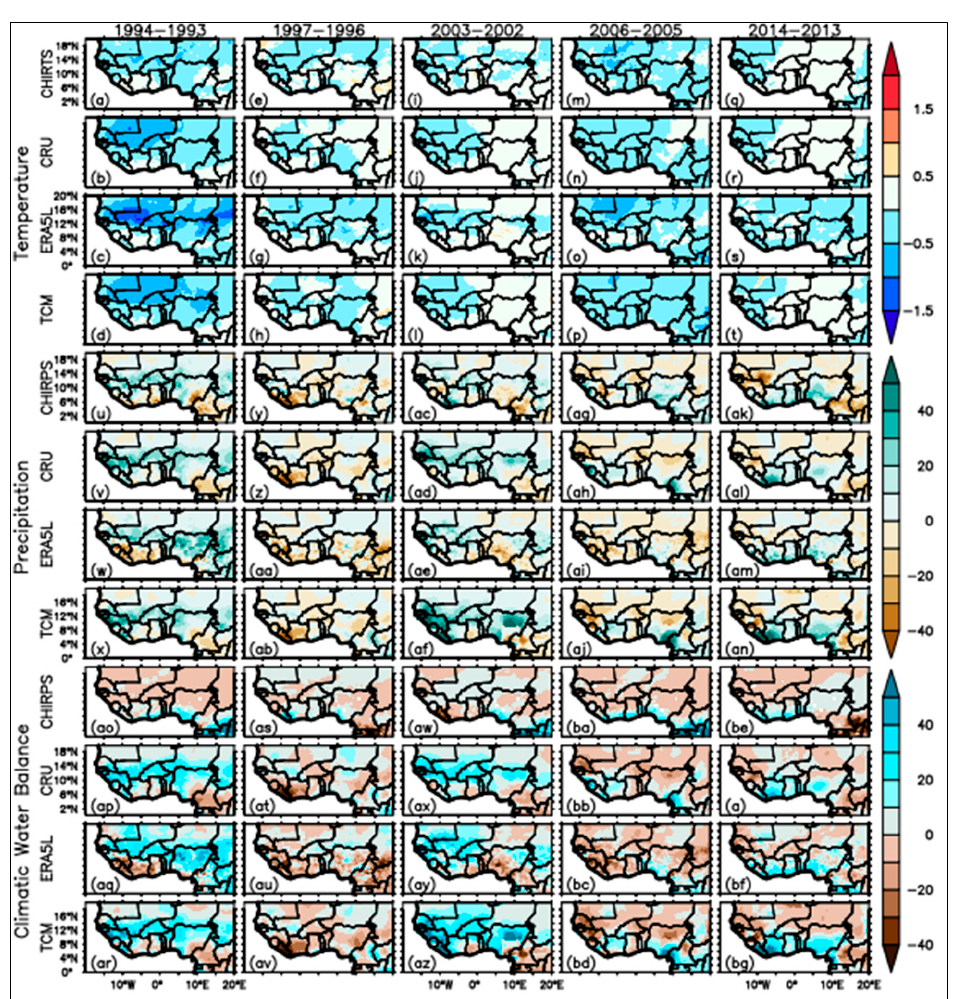
Figure 10. ( a – bg ) Changes in climatic conditions in normal years with no abrupt land cover